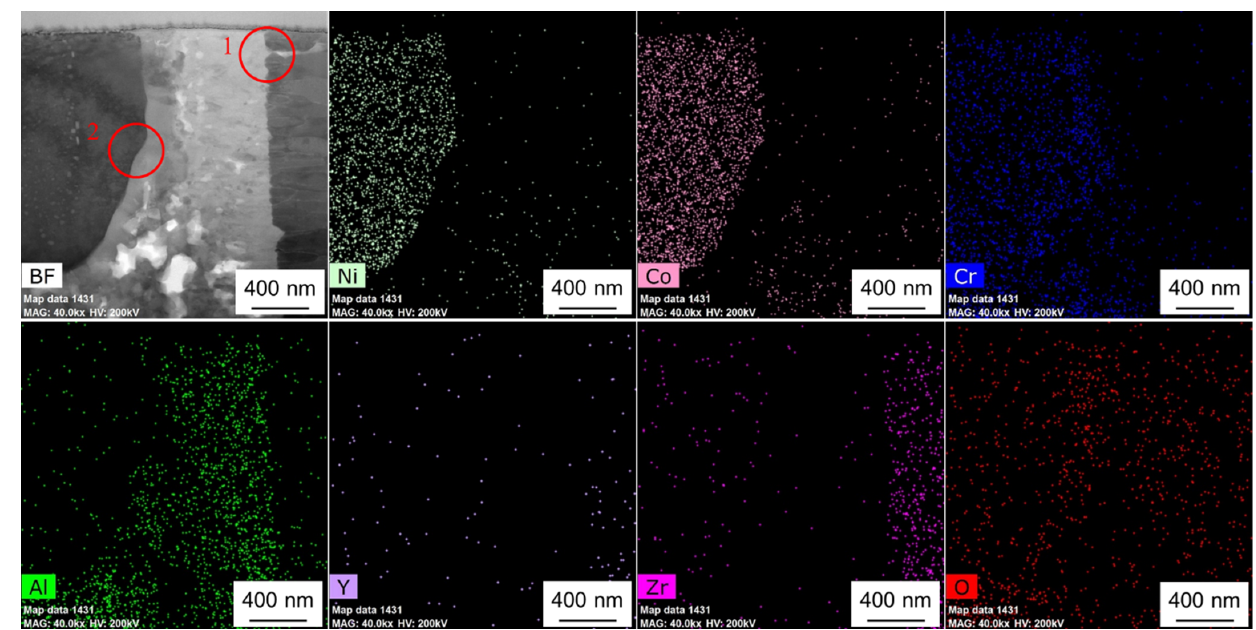
Figure 5. STEM-EDS elemental maps of the observation area.